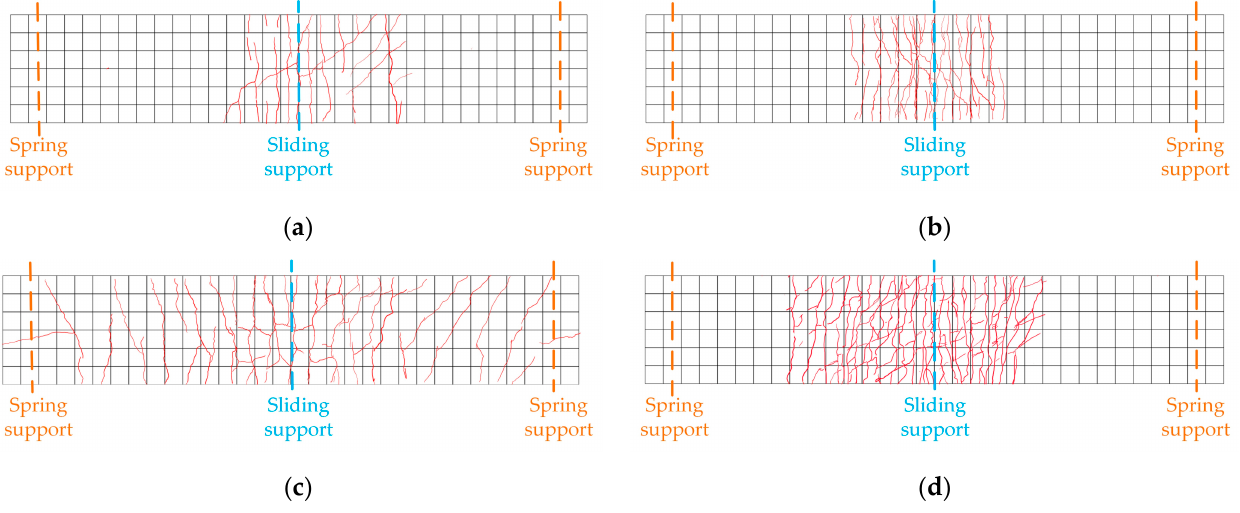
Figure 10. Crack development at top of the slab: ( a ) specimen SNF; ( b ) specimen SNC; ( c ) specimen SEF; ( d ) specimen SEC. SEF; ( d ) specimen